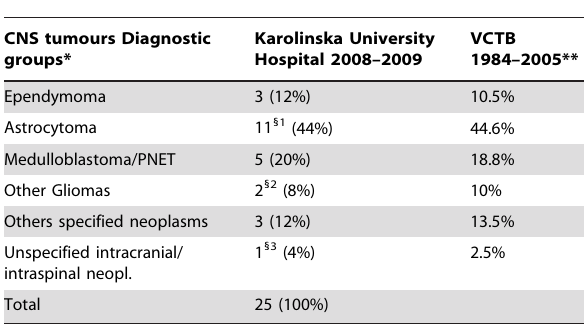
Table 2. Relative frequencies of tumour biopsies in the main diagnostic groups for CNS tumours as compared to their frequencies in the whole of Sweden.